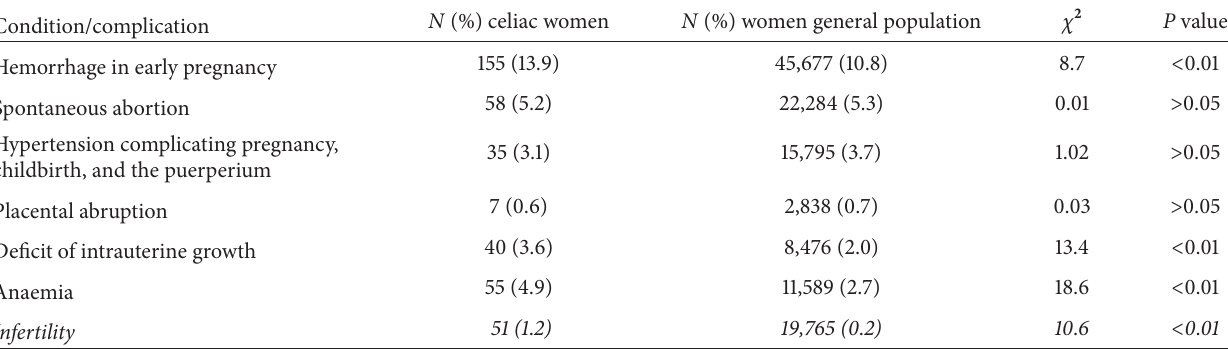
Table 5: Hospitalization among celiac women and women from the general population (both aged 15–49 years), by condition/complication, years